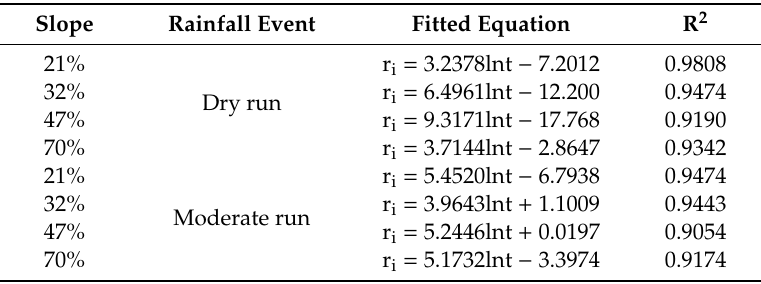
Table 3. Fitted equations of runo ff rate with